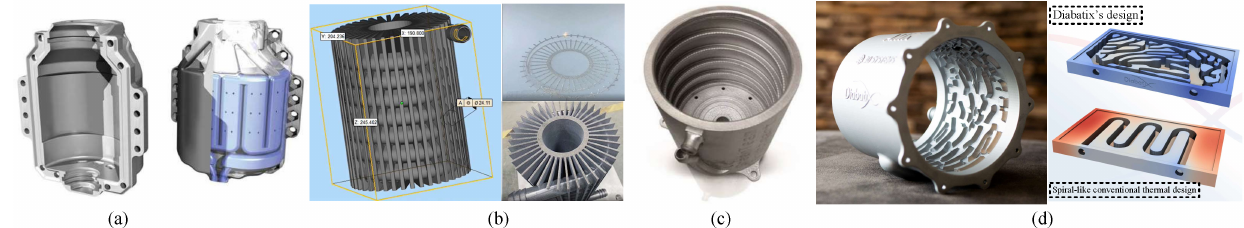
Figure 20. Examples of 3D-printed electrical machine housing: ( a ) Motor housing with integrated cooling channels [53], ( b ) AM heat exchanger with spiral-fins using SLM [54], ( c ) Cooling jacket with internal helix structure [55], ( d ) Diabatix’s thermal cooling design with artificially designed patterns